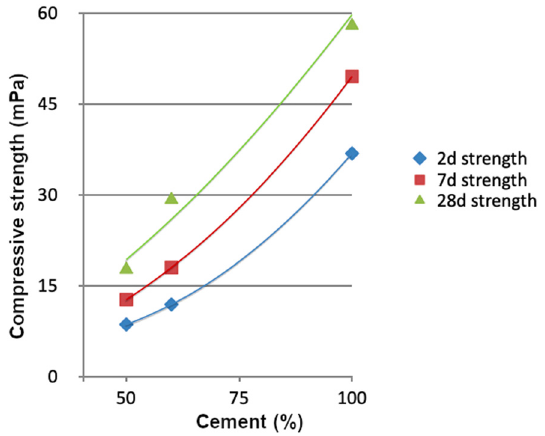
Figure 8: Compressive strength as a function of cement content for varied curing